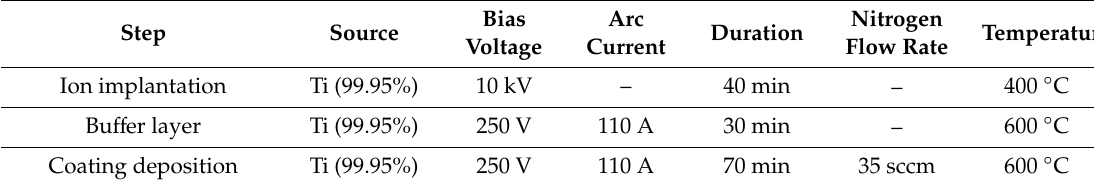
Table 3. Deposition parameters of TiN